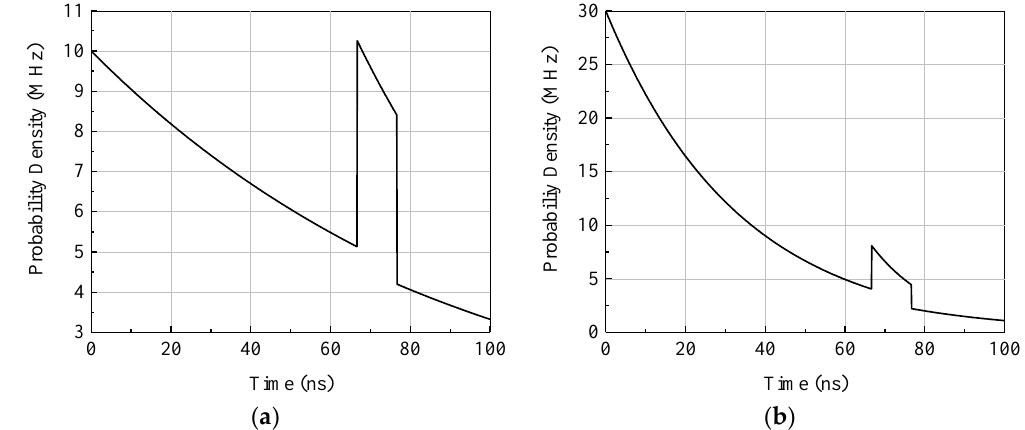
Figure 2. ( a ) Probability density of the first photon detection for measurement duration of 100 ns, a pulse width of 10 ns, and a TOF of 67 ns. The photon rates are assumed to be 10 MHz for the laser pulse and background light; and ( b ) the probability density for photon detection rates of 30 MHz achieved by increasing the PDE or target reflectance by a factor of three.